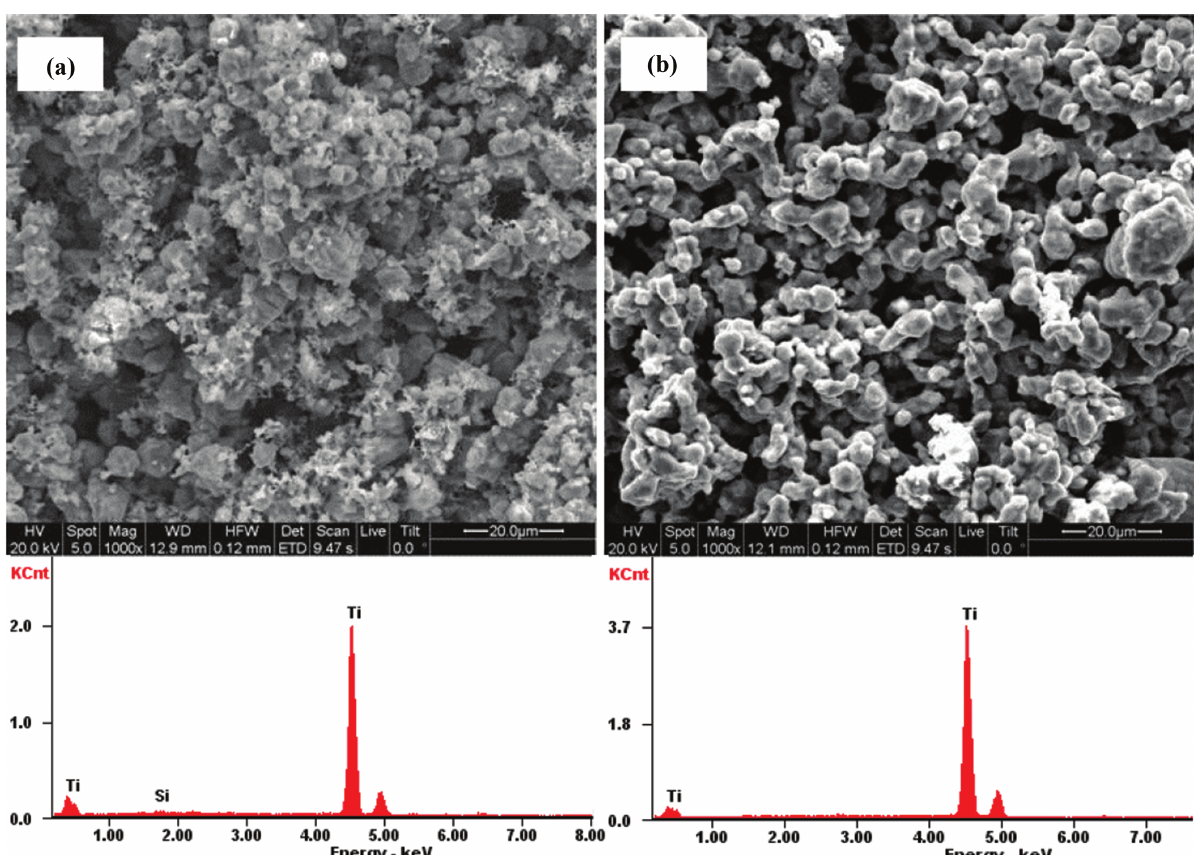
Figure 6: SEM images and EDX spectra of the electrolytic products at 1,100 ℃ for different times (a) 4 h and (b) 6 h. The pellets were pressed under 3 MPa.